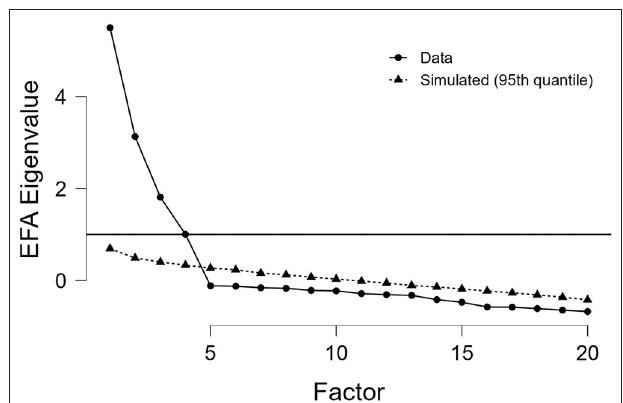
FIGURE 1 | Scree plot of the